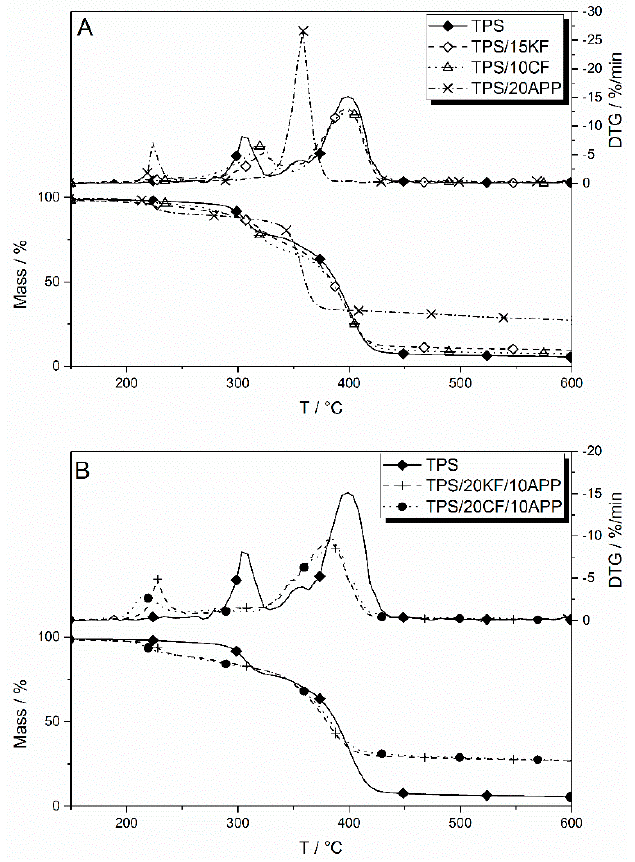
Figure 9. Mass and mass loss rates (DTG) of TPS blended with single natural fibre components or APP ( A ) and of combinations of TPS with natural fibres and APP ( B ).